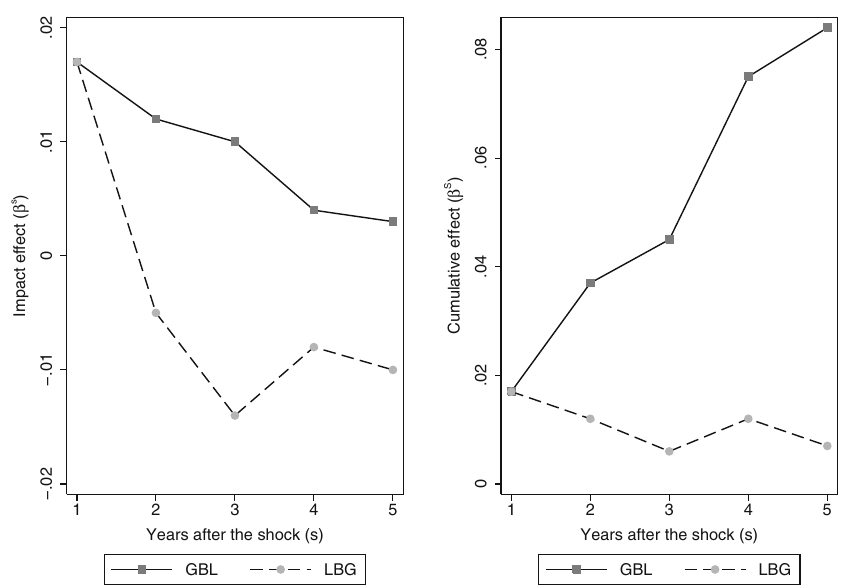
Fig.3 EstimatedGBLandLBGeffects. Notes. Thesolidlineplottheestimatedgrowingbylearning(GBL) effects. The dashed line plots the learning by growing (LBG) effects. The left panel shows the cumulative effect ( β S h ) on either employment (GBL) or productivity (LBG) growth while the right panel shows impact effects ( β s LBG